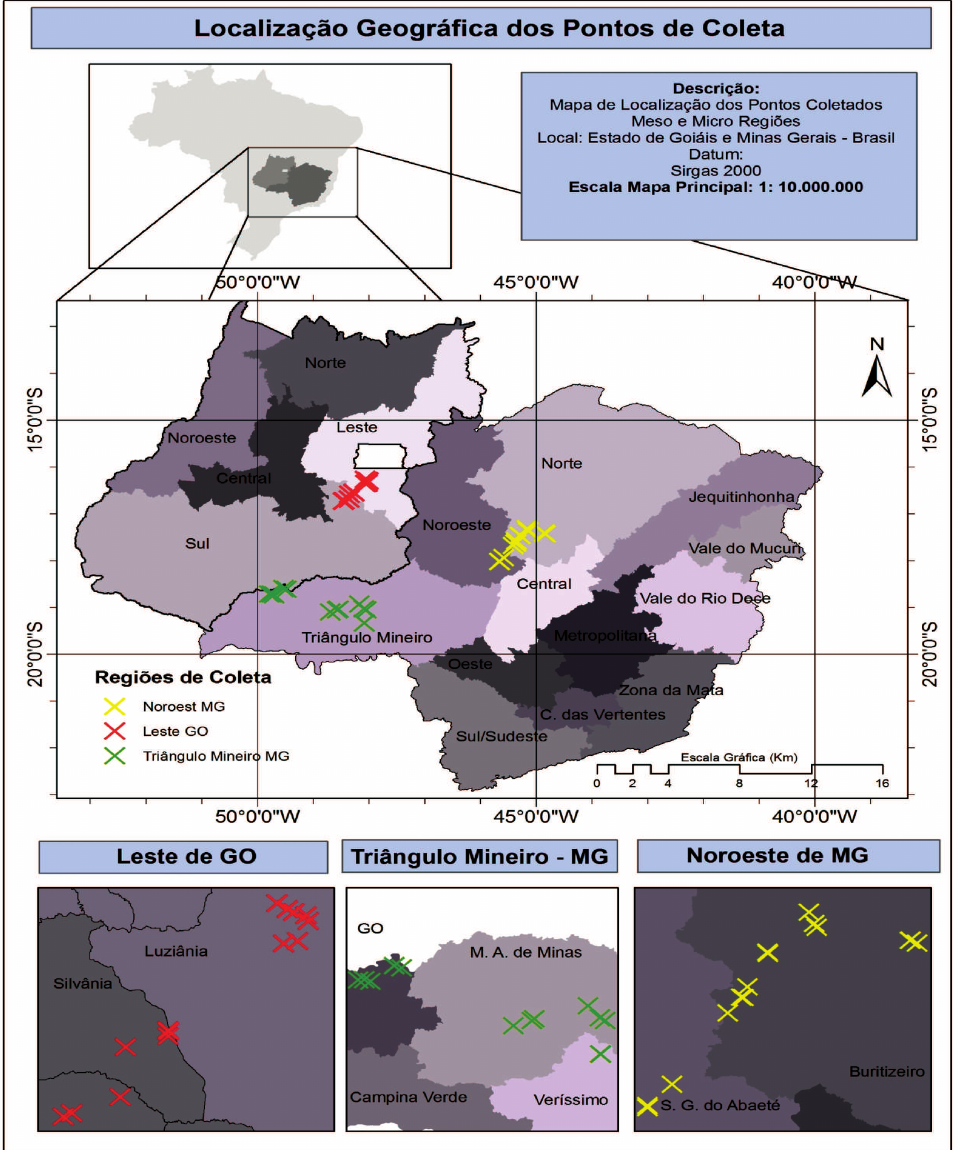
Figura 1. Mapa da localização das sub-regiões G (Leste de GO); T (Triângulo Mineiro, MG); e N (Nordeste de